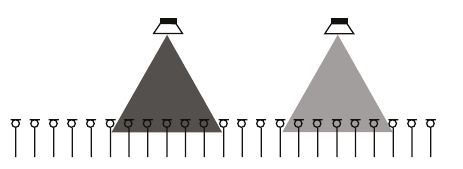
Figure 7: Measurement selection for individual